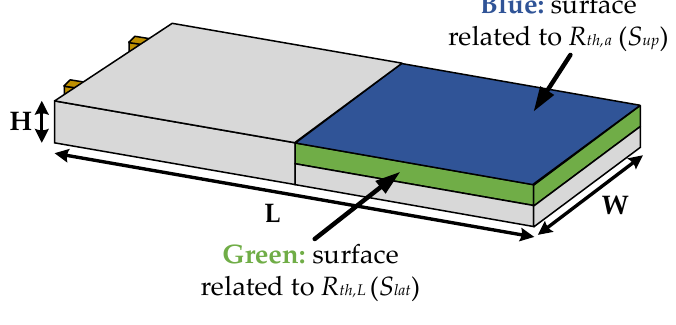
Figure 4. Battery cell.